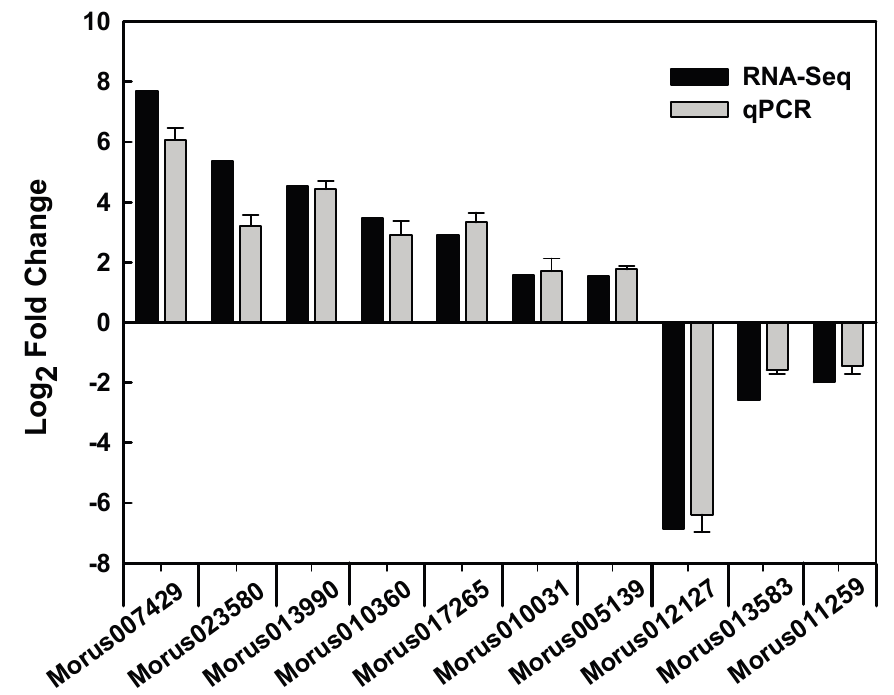
Figure 4. Verification of RNA-Seq results by